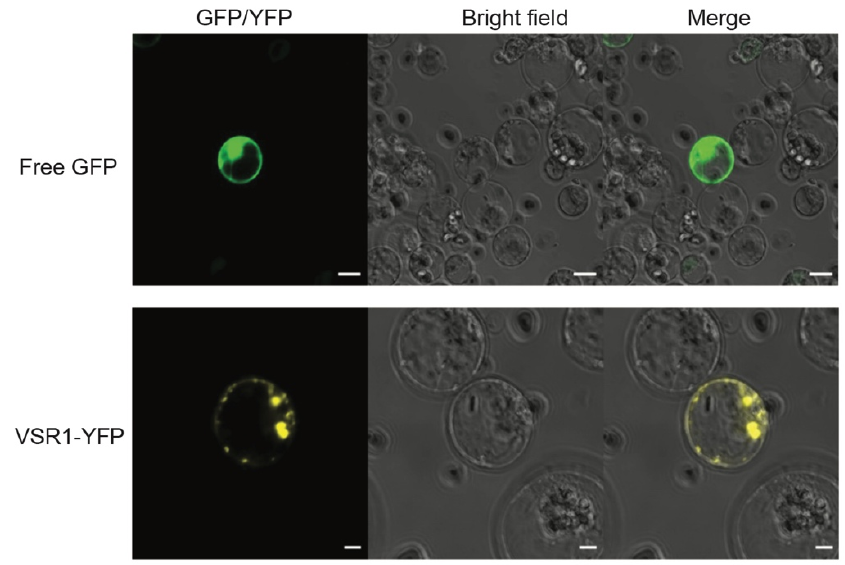
Figure 5. Subcellular localization of VSP1 in banana protoplasts. Subcellular localization of free GFP and Arabidopsis VSP1-YFP in banana protoplasts. GFP Bars, 10 μ m; VSP1-YFP Bars, 5 μ m.